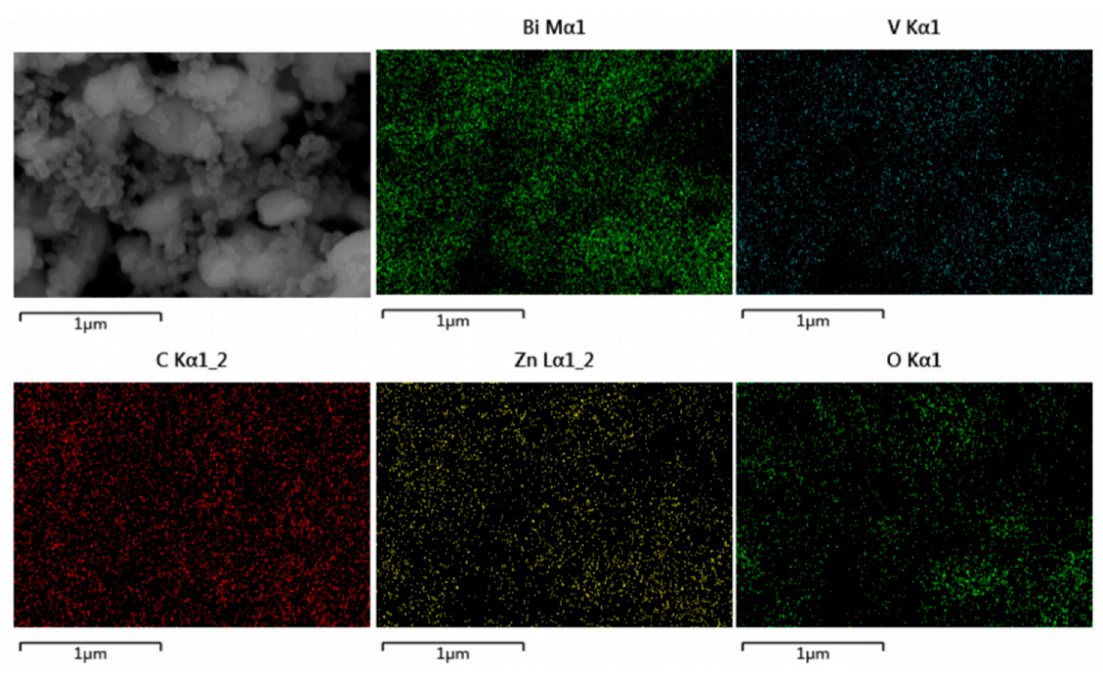
Figure 3. Energy dispersive spectroscopy (EDS) element mapping of ZIF-8@BVO composite.